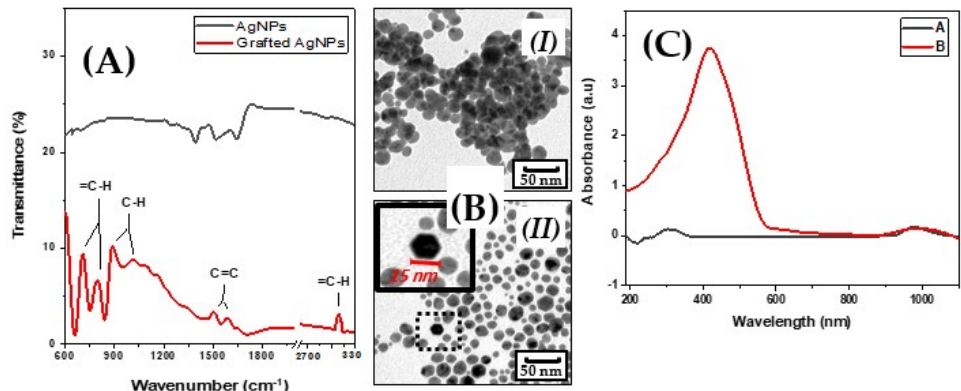
Figure 2. Confirmation of successful modification of AgNPs by IR spectroscopy ( A ); morphology of silver nanoparticles (AgNPs) determined by TEM ( I ) before grafting and ( II ) after grafting ( B ); absorbance spectrum of aqueous silver solution ( I ) and of deionized water in which the samples were soaked ( C ).